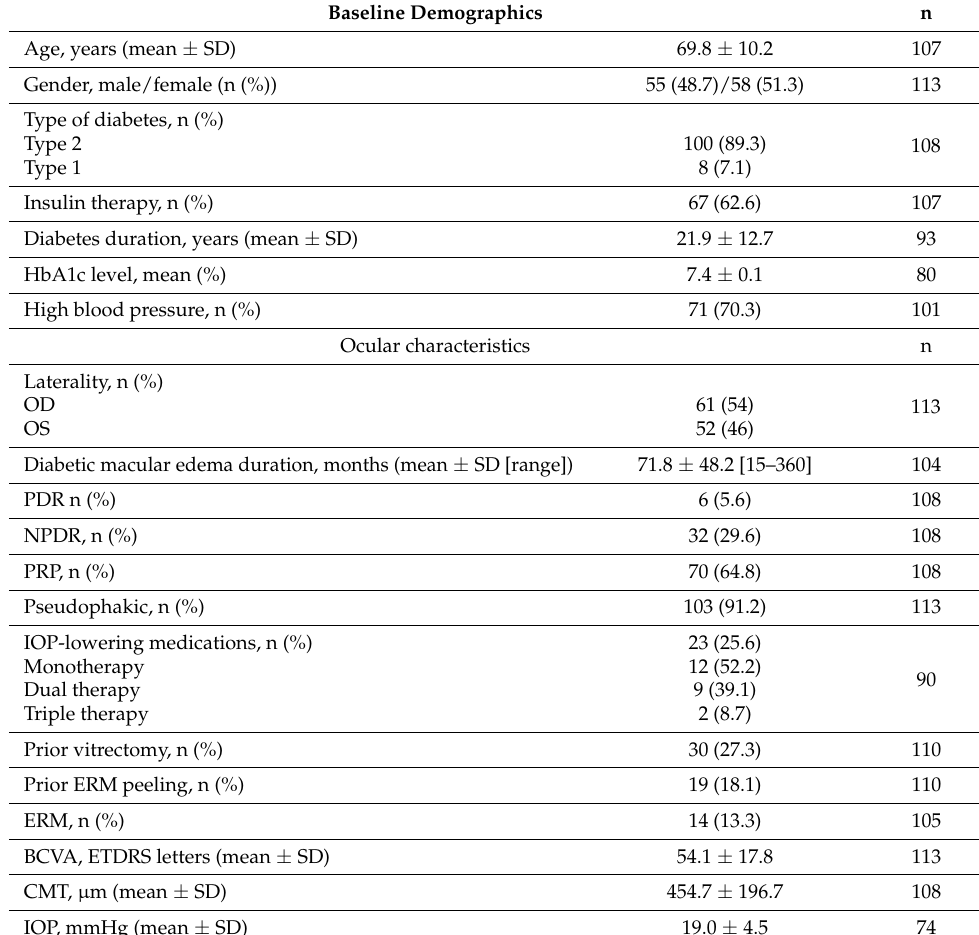
Table 1. Baseline demographics and ocular characteristics. BCVA, best-corrected visual acuity; CMT, central macular thickness; ERM, epiretinal membrane; ETDRS, early treatment diabetic retinopathy study; IOP, intraocular pressure; NPDR, non-proliferative diabetic retinopathy; PDR, proliferative diabetic retinopathy; PRP, panretinal photocoagulation; SD, standard